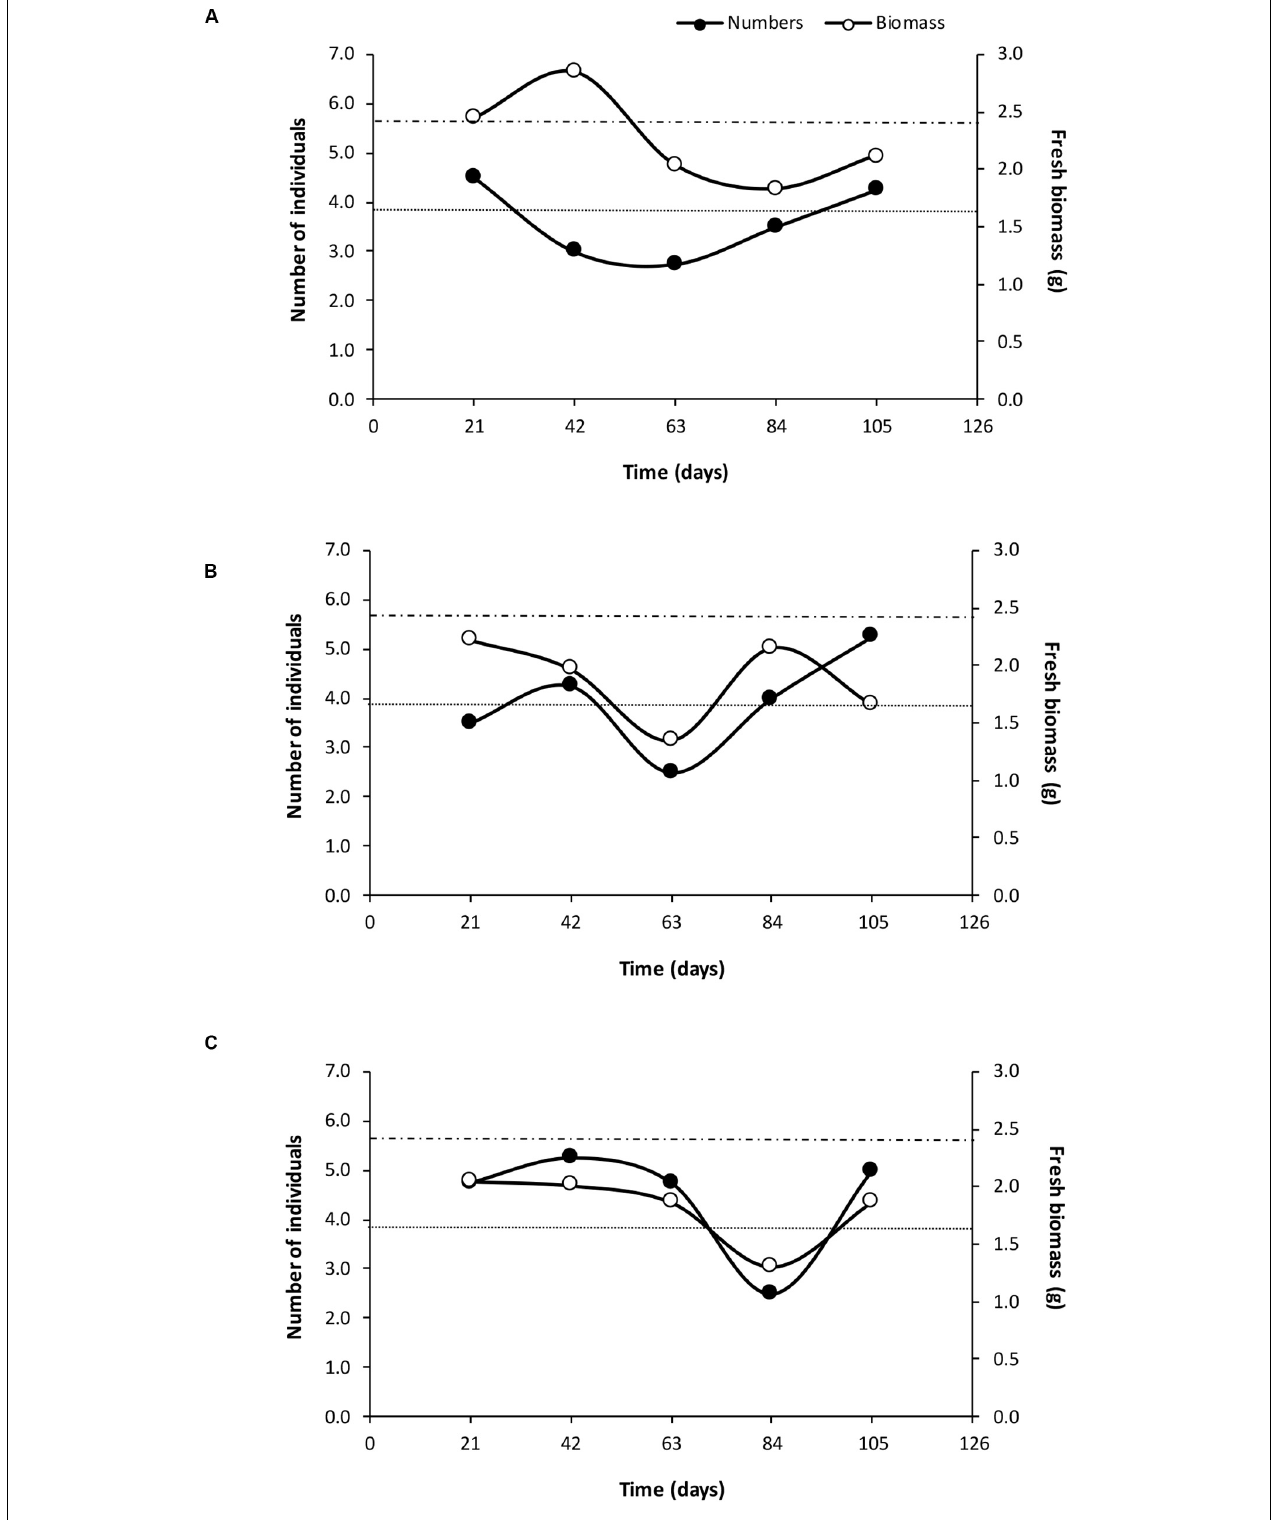
FIGURE 2 | Changes in the average values of earthworm numbers and fresh biomass at each agricultural management treatment with earthworm additions [ (A) CONV + EW, (B) INT + EW, and (C) ORG + EW] during the incubation period. Upper dashed line indicates initial biomass and bottom dotted line initial number of individuals inoculated in the experimental